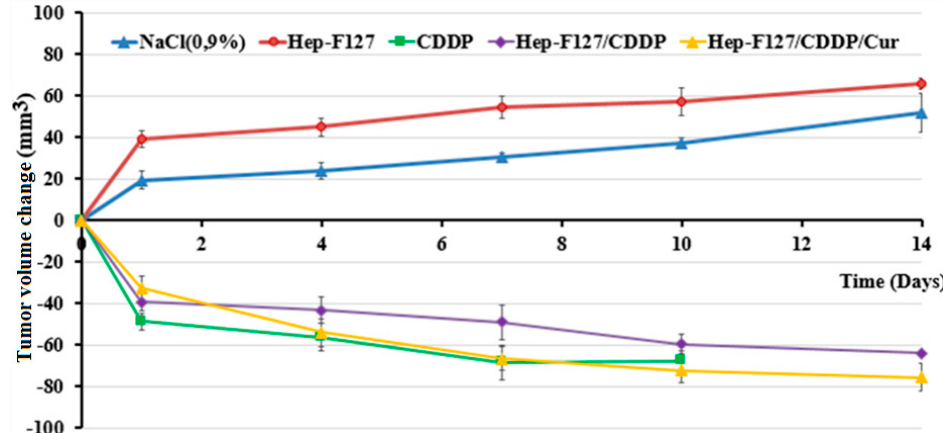
Figure 8. Volume behavior of tumors treated with normal saline control, CDDP, Hep-F127, Hep-F127/Cur, Hep-F127/CDDP and Hep F127/CDDP/Cur over